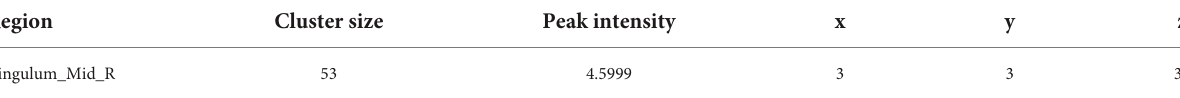
TABLE 4 Brain area with a significant difference in hypothalamus FC between the two